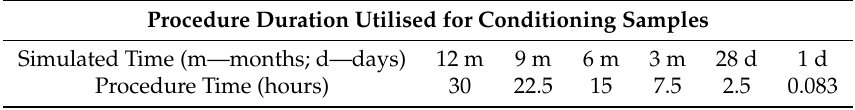
Table 6. Simulated time periods utilised for conditioning test